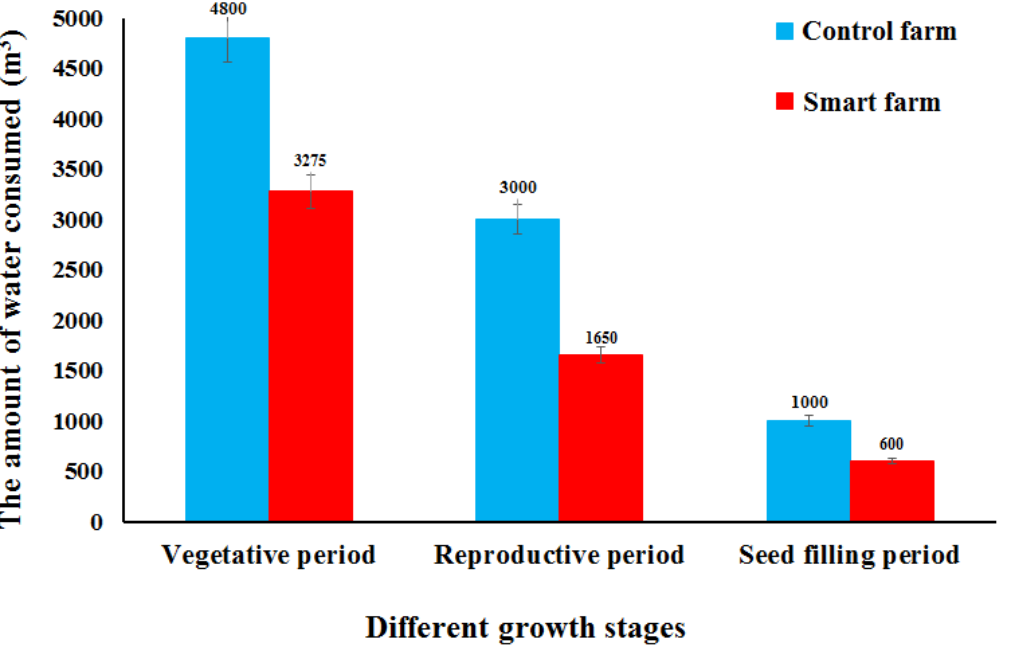
Figure 5. Irrigation status per hectare in three periods of growth, reproduction and seed maturity.